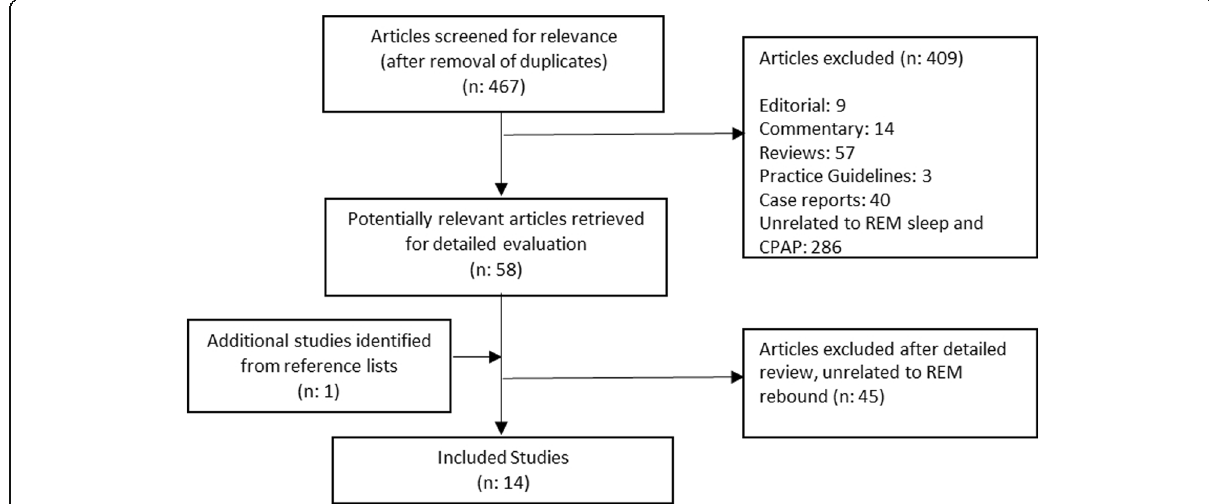
Fig. 1 Flowchart for study